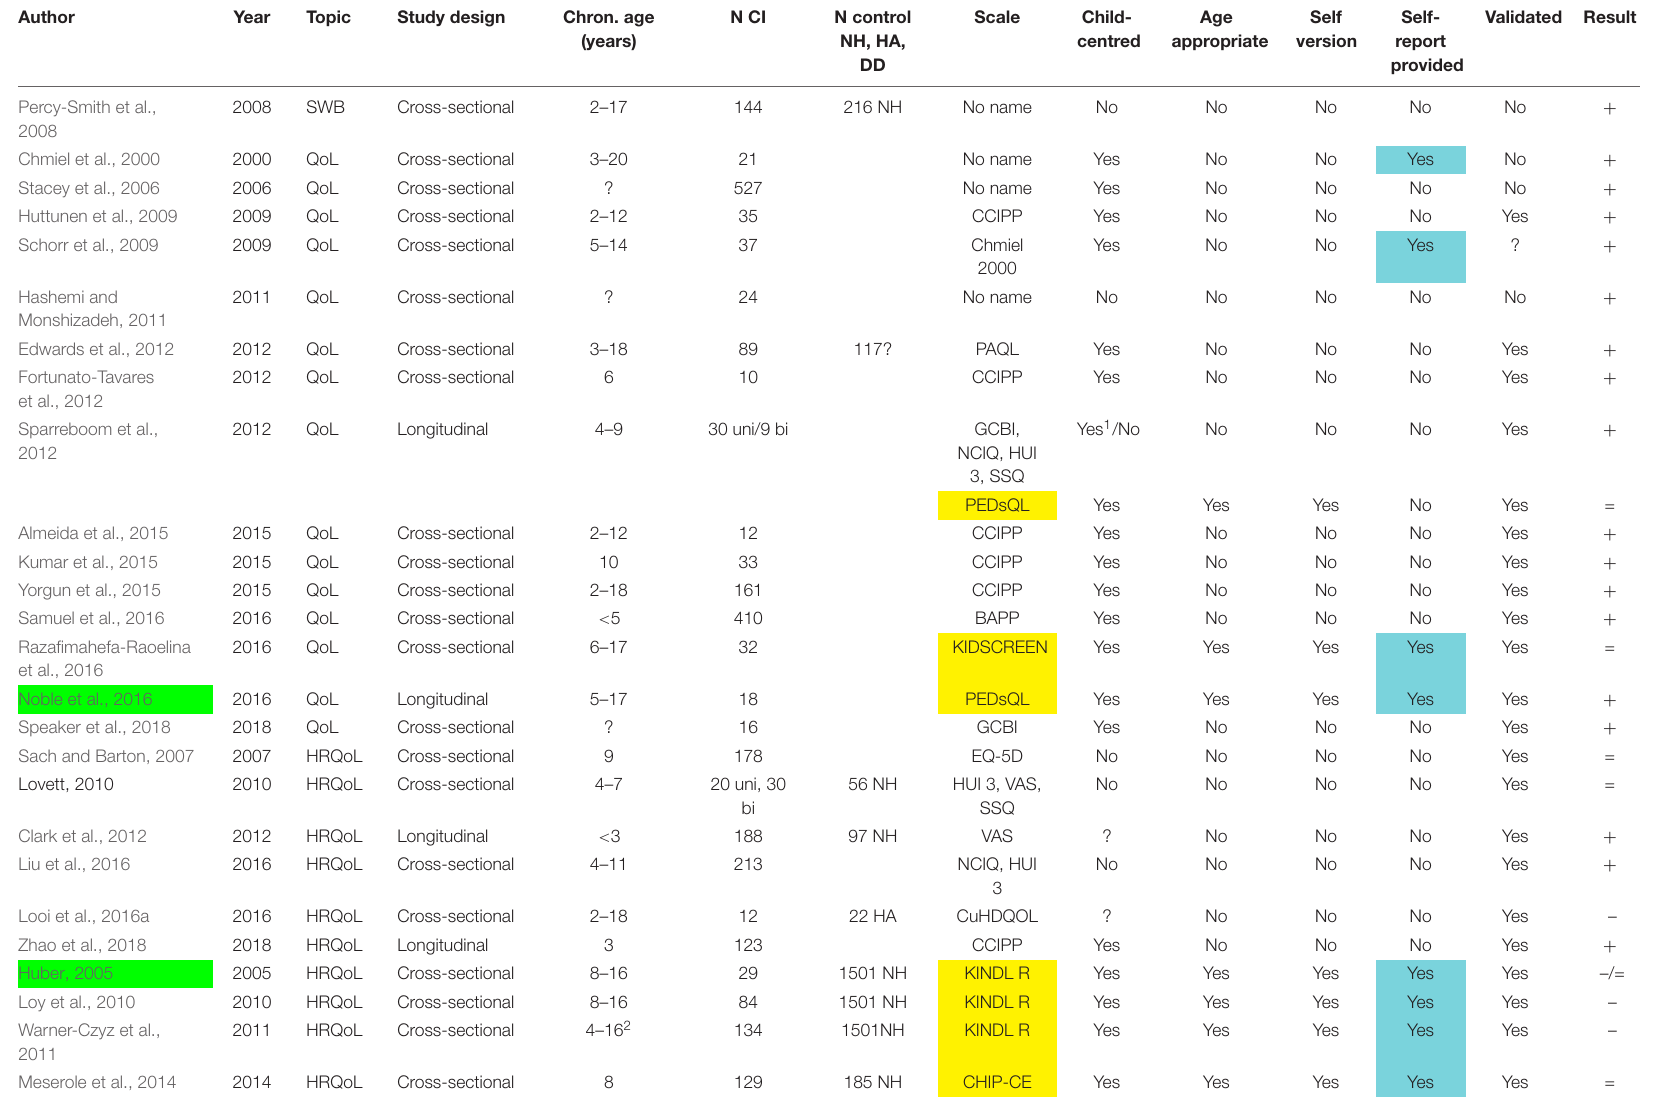
TABLE 1 | Studies addressing quality of life of children and adolescents with